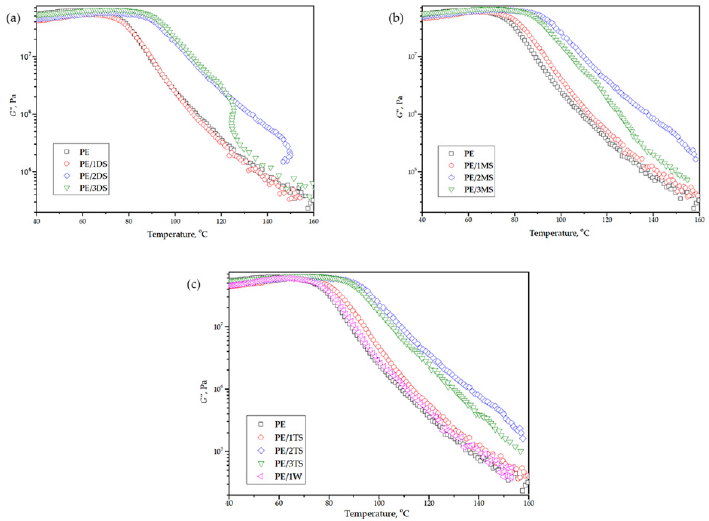
Figure 14. Temperature dependence of loss modulus (G”) of plain epoxy and corresponding composites for ( a ) PE, PE/1DS, PE/2DS, and PE/3DS ( b ) PE, PE/1MS, PE/2MS, PE/3MS ( c ) PE, PE/1TS, PE/2TS, PE/3TS, and PE/1W.